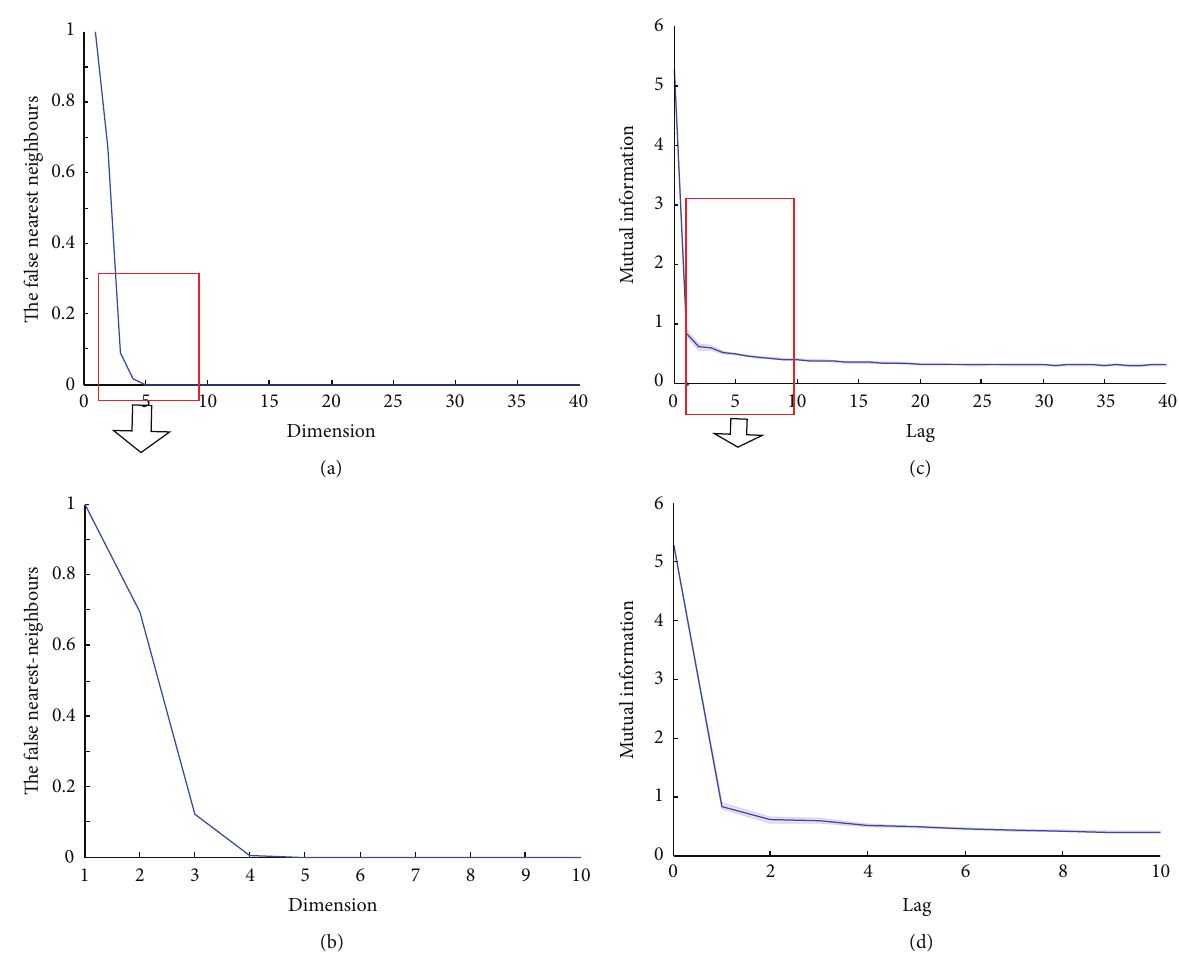
Figure 3: The embedding dimension and delay time of the EEG signals during the burst suppression state. (a) The false nearest neighbors versus the dimension with scales from 0 to 40. (b) The local plot of (a) with the dimension scales from 1 to 10. (c) The mutual information versus the delay time with scales from 0 to 40. (d) The local plot of (c) with the delay time scales from 1 to